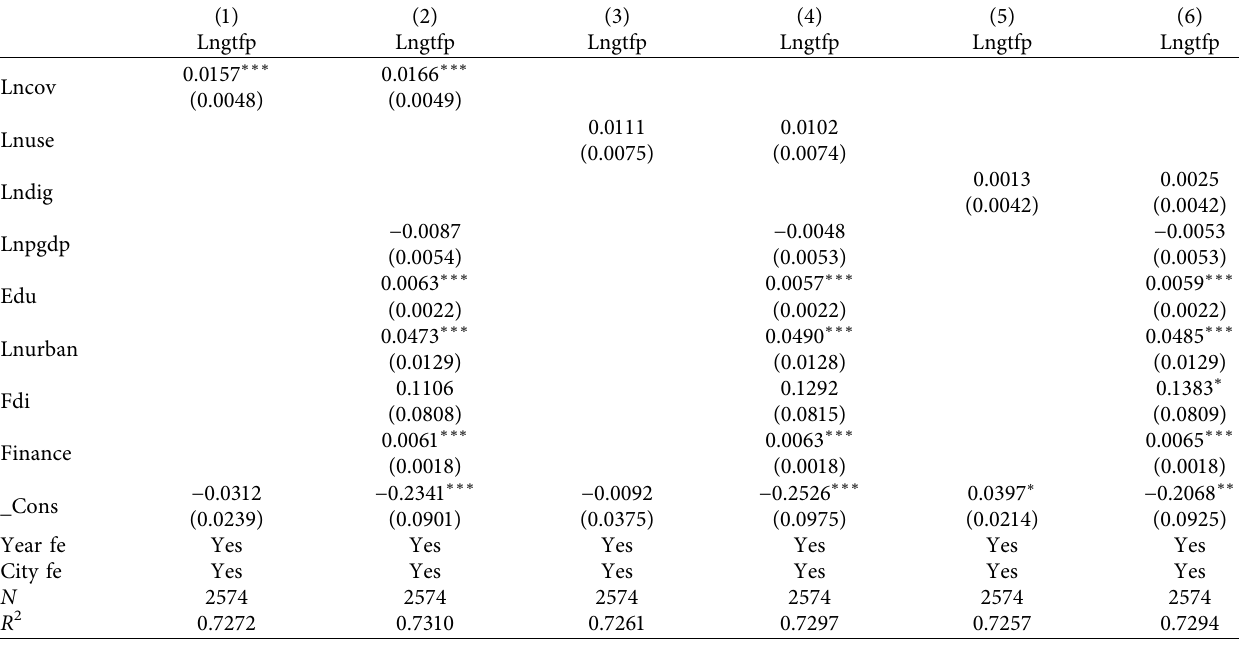
Table 5: Internal mechanism of digital finance influencing green